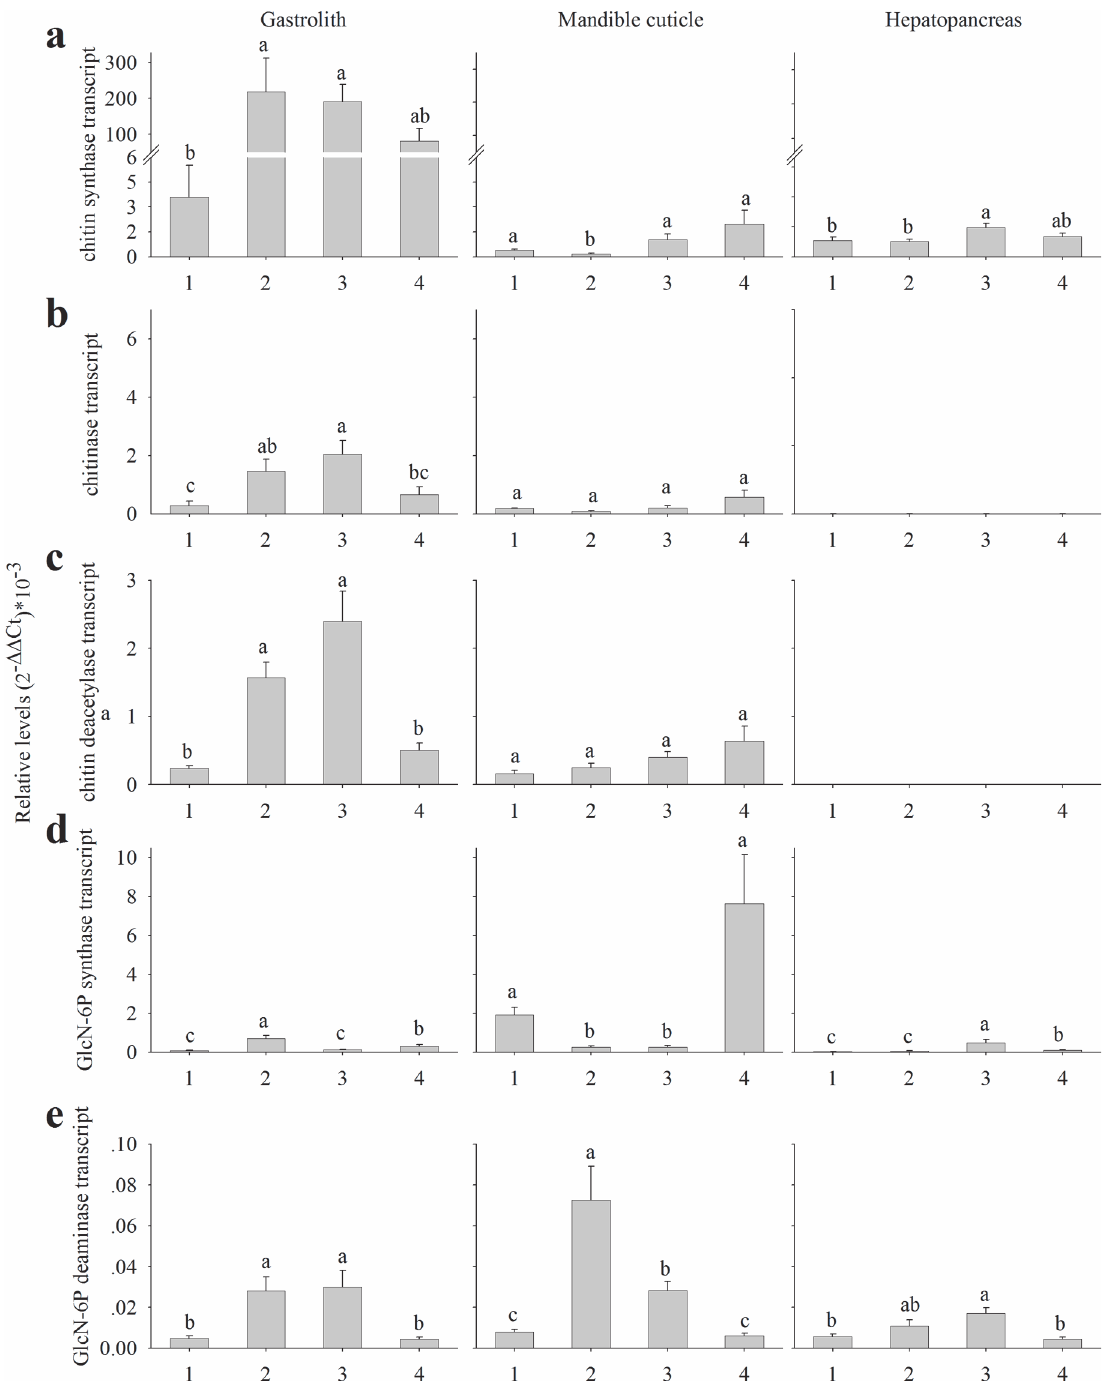
Fig 6. Relative levels of key chitin metabolism-related genes transcript. Relative levels of key chitin metabolism-related genes transcript from the gastrolith-forming epithelium (left), the mandible cuticle-forming epithelium (middle) and the hepatopancreas (right), as determined by qPCR. Numbers on the X axis represents the four molt stages, 1 inter-molt (n = 5), 2 early pre-molt (n = 6), 3 late pre-molt (n = 6) and 4 post-molt (n = 6). Presented transcripts are (a) chitin synthase, (b) chitinase, (c) chitin deacetylase, (d) GlcN-6P synthase and (e) GlcN-6P deaminase. Letters represent statistical groups which are significantly different ( p -value < 0.05), error bars represents standard